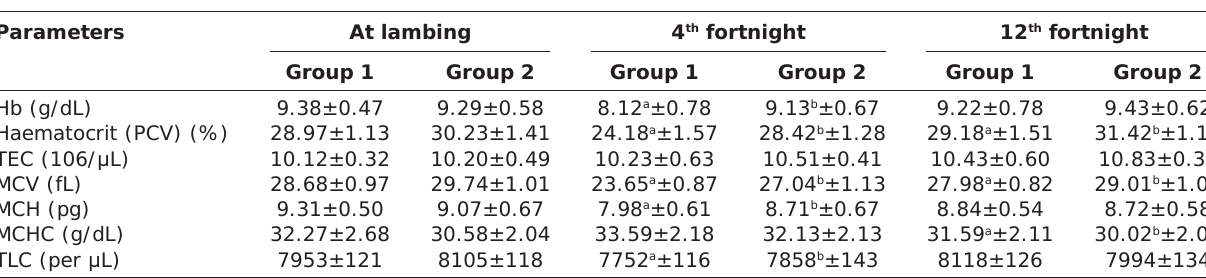
Table-2: Haematological profiles in ewe